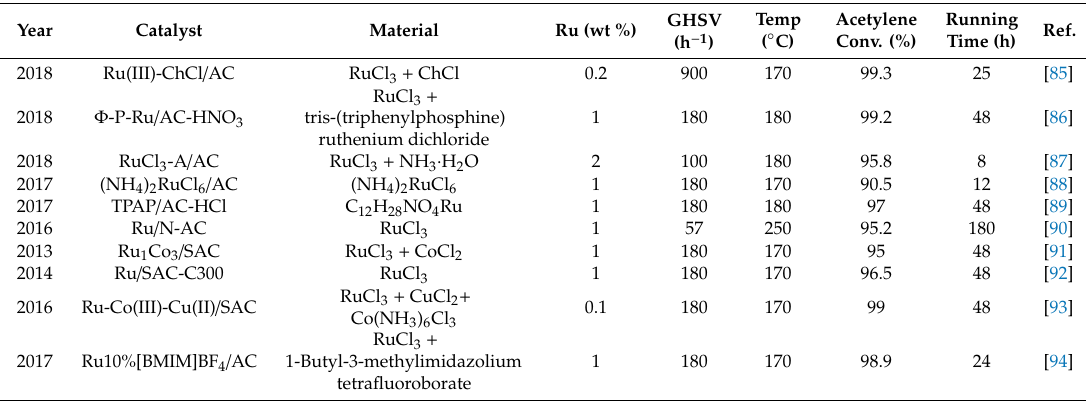
Table 3. Performance of Ru catalysts for acetylene hydrochlorination.